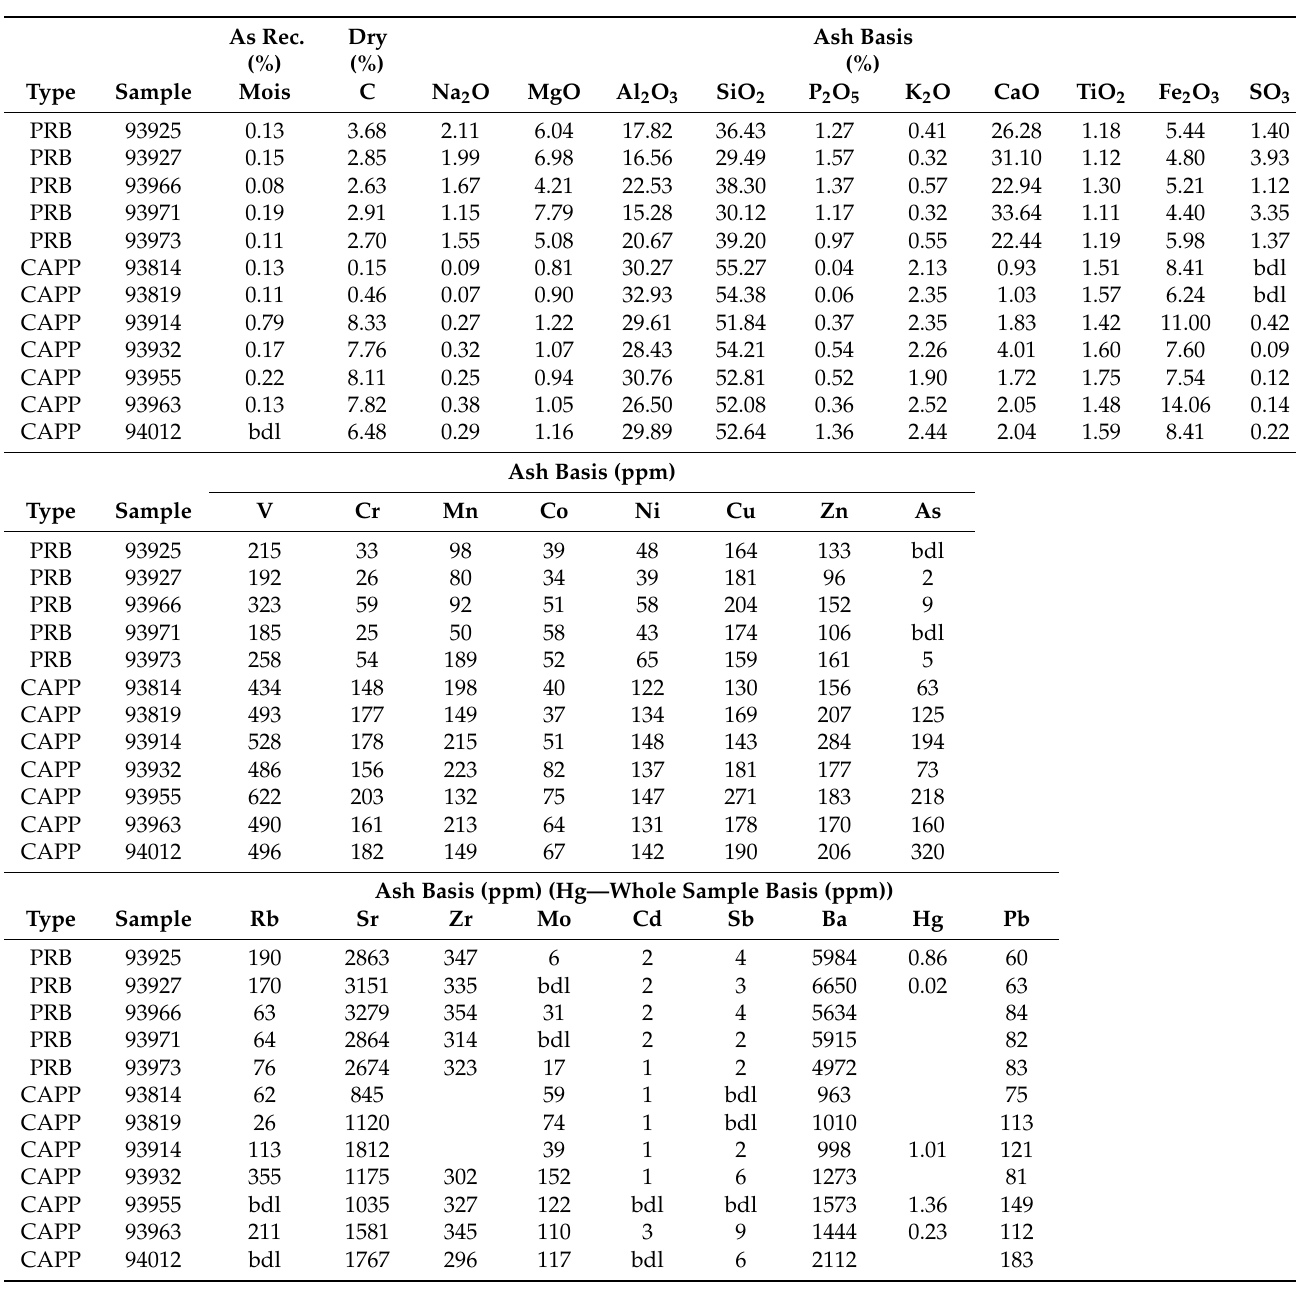
Table 1. Comparison the fly ash chemistry for Powder River Basin (PRB) coal-derived and Central Appalachian (CAPP) coal-derived fly ashes. Data from University of Kentucky Center for Applied Energy Research studies. bdl—below detection